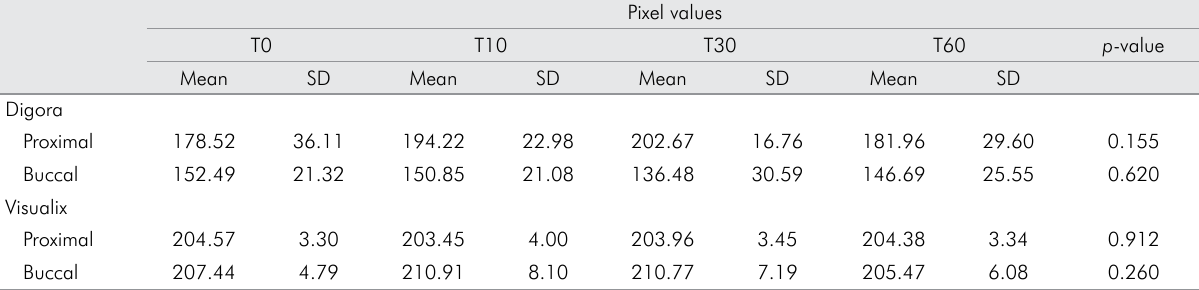
Table 2. Means and standard deviations of the pixel values analyzed with the Digora™ and Visualix™ systems that were obtained at the different times of ERR induction (ANOVA).